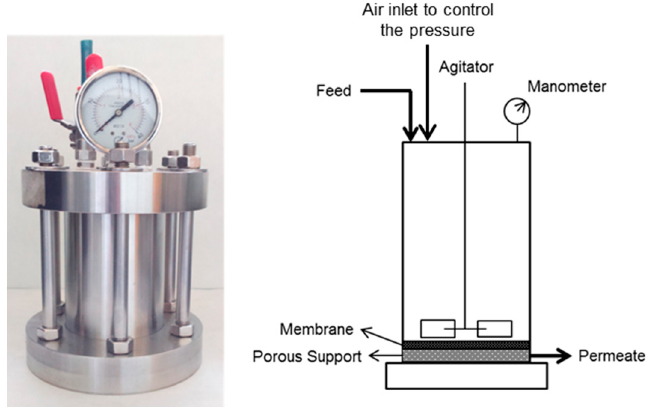
Figure 2. Membrane pilot plant.